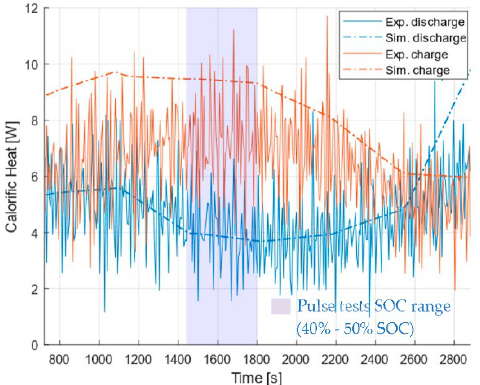
Figure 4. Battery cell model heat generation validation with experimental heat generation information (80–20% SOC range).